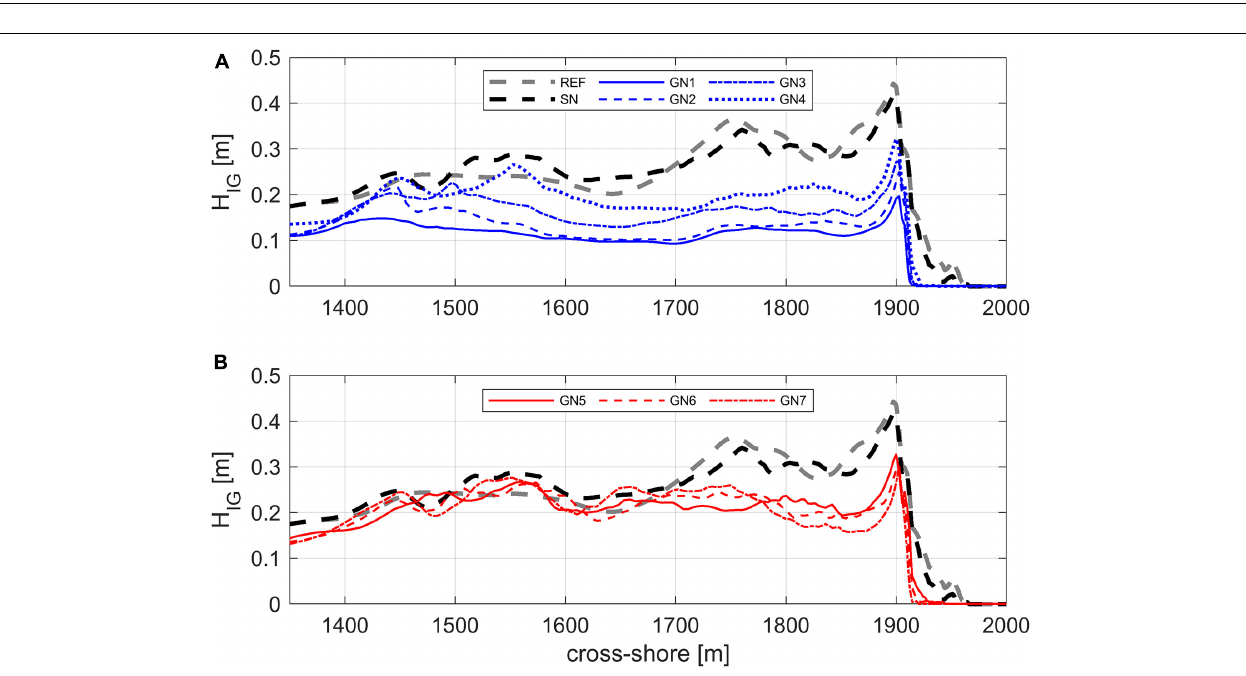
FIGURE 5 | Cross-shore infragravity wave height (H IG ) distribution under mild wave (i.e., H m = 1.5 m, T = 8 s) for: (A) case REF, SN, GN1-4; and (B) case GN5-7.